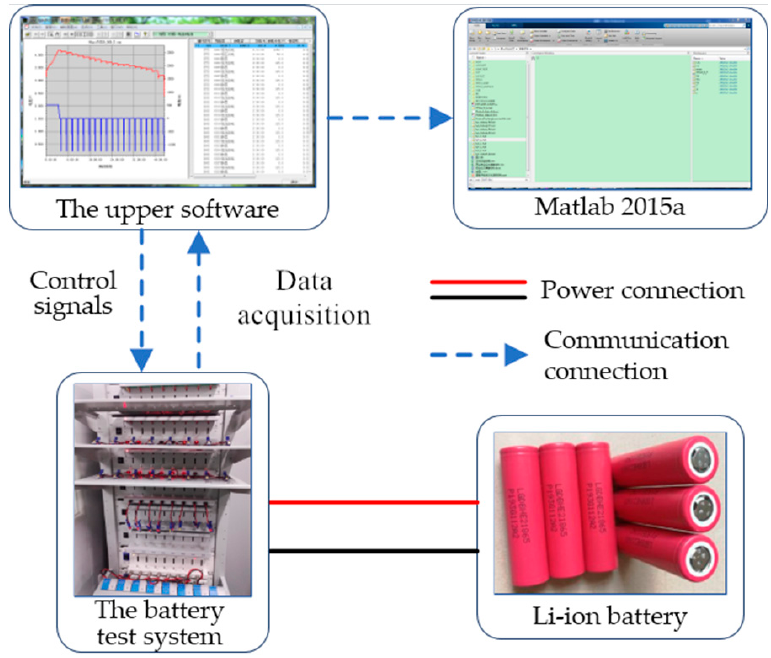
Figure 3. The experimental platform.